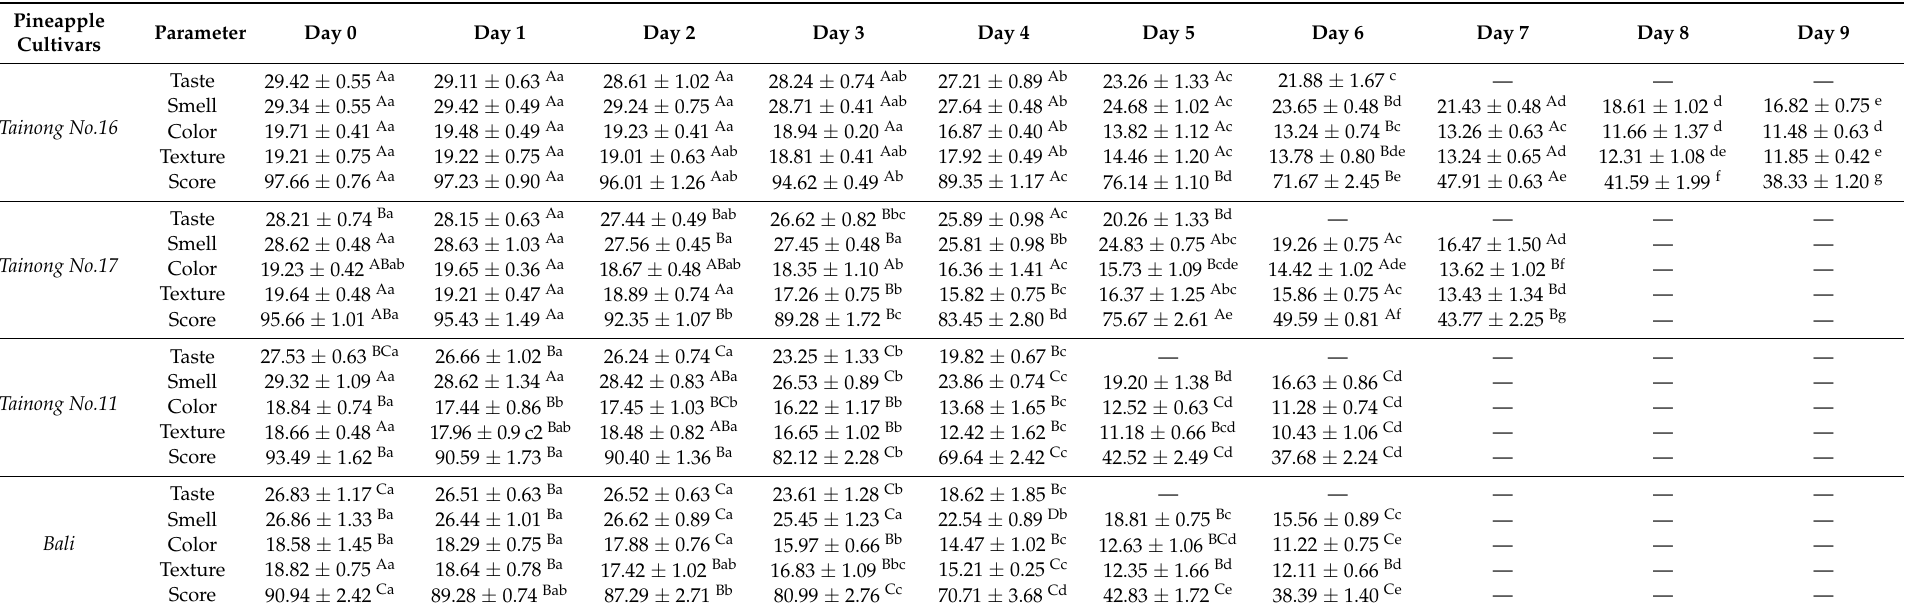
Table 3. Changes in sensory scores in freshly cut pineapple during